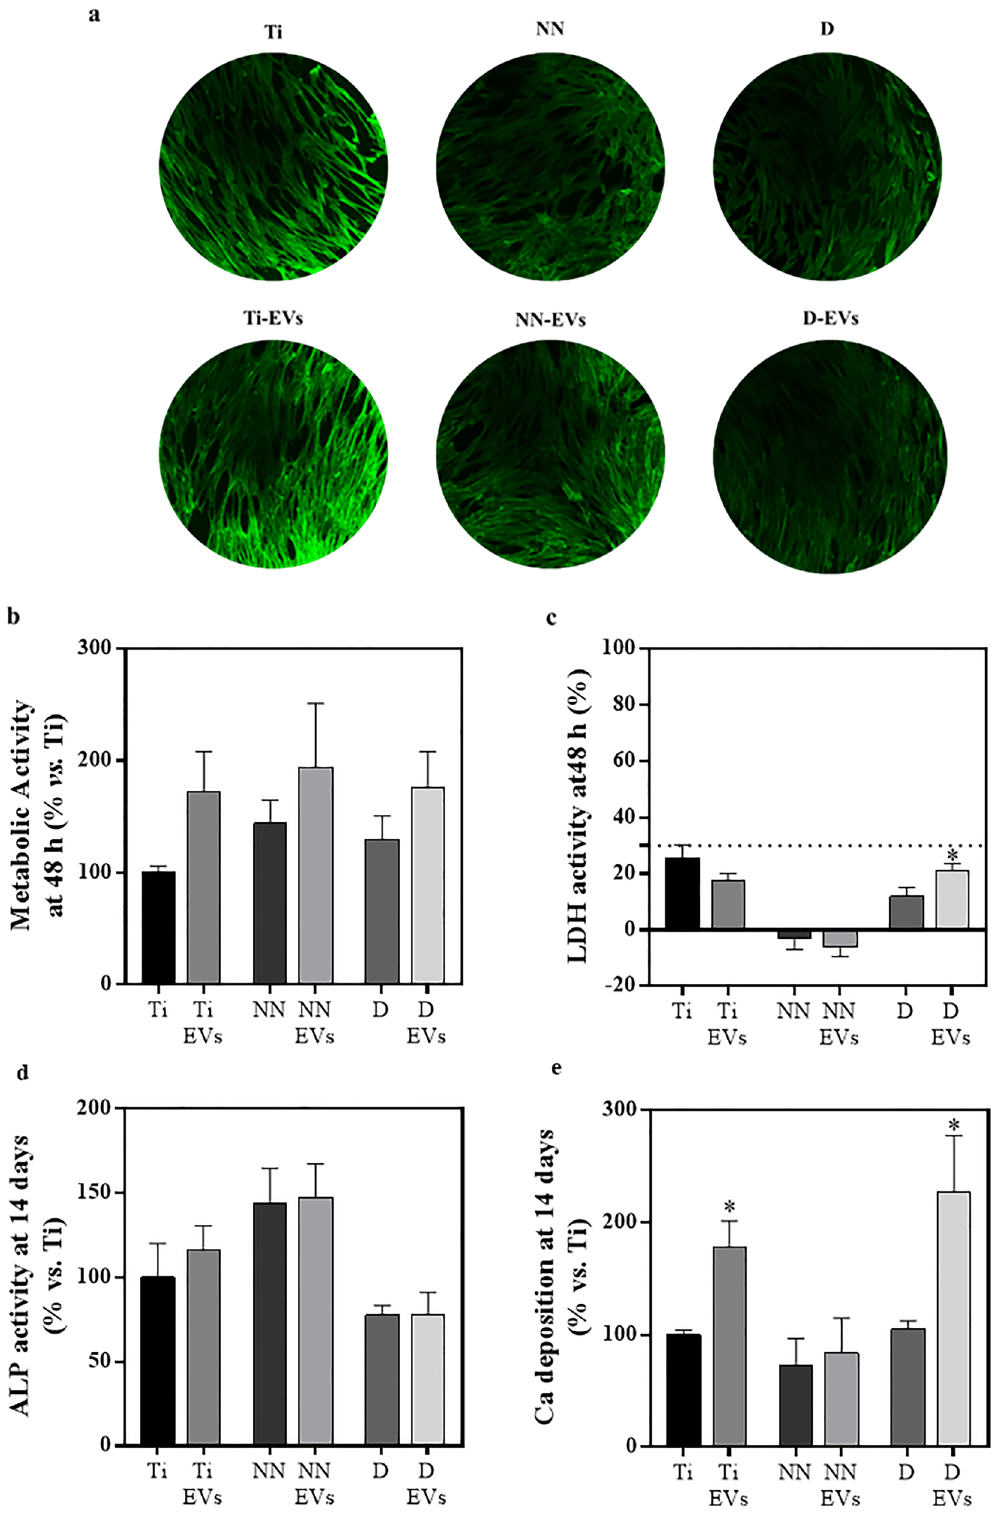
Figure 4. In vitro biocompatibility and MSC osteogenic differentiation. ( a ) Confocal images of implants surface after 48 h of MSC growth. Green signal corresponds to actin filaments. ( b ) Metabolic activity after 48 h of treatment, data of Ti group was set as 100%. ( c ) LDH activity measured in cell culture media after 48 h of cell growth. Cells seeded on TCP were set as 0% while cells treated with triton were set as 100% of LDH activity. A dashed line is added at 30% of LDH activity. ( d ) ALP activity after 14 days of cell culture. Ti ALP activity is set as 100%. ( e ) Ca deposition after 14 days of cell growth, Ca 2+ levels of Ti were set as 100%. Three independent experiments were performed, each of them with three different samples for Ti, Ti-EVs, D and D-EVs (n = 9), while only two independent experiments were performed for NN and NN-EVs (n = 6). Values represent the mean ± SEM. Metabolic activity, LDH activity and Ca deposition were compared with t-test comparisons. Statistically significant differences were considered for p < 0.05 and represented with * compared to the respective control group without EV